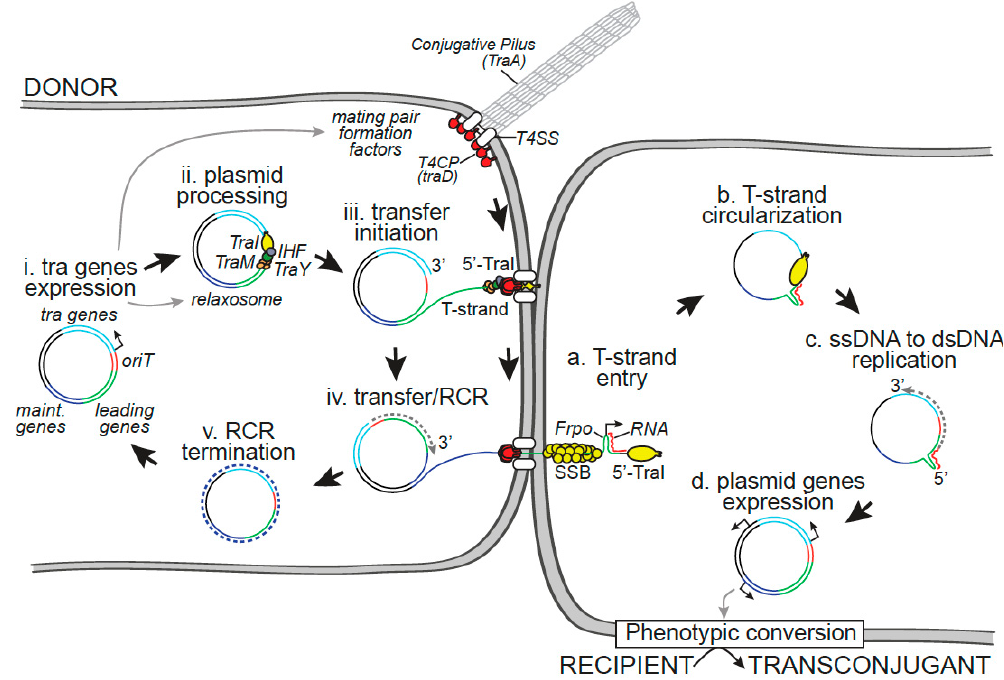
Figure 1. Schematic diagram of the life cycle of the F plasmid during conjugational transfer from the donor to the recipient cell. This F plasmid backbone is composed of the tra regions encoding all genes involved in conjugational transfer (light blue); the origin of transfer oriT (red); the leading region (green), which is the first to be transferred into the recipient cell; and the maintenance region (dark blue) involved in plasmid replication and partition. ( i ) The initiation of conjugation requires the